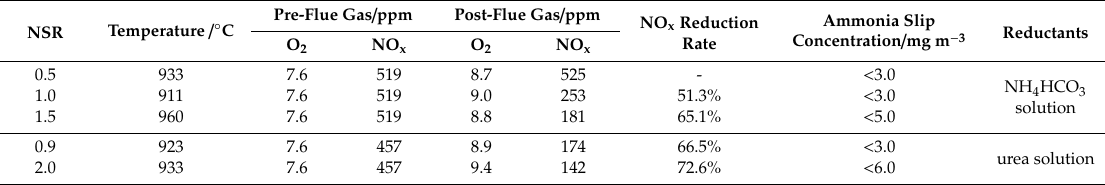
Table 1. E ff ects of reductants on the NO x reduction with di ff erent NH 3 / NO x molar